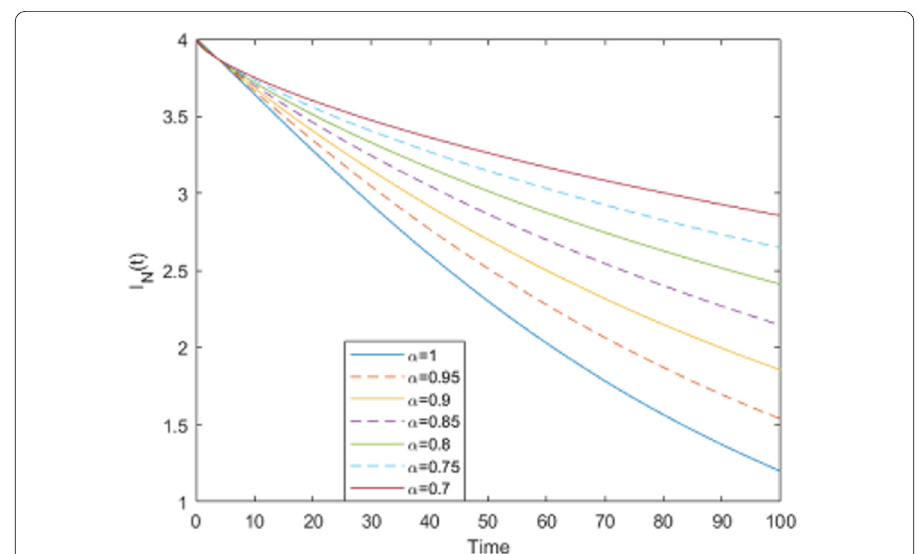
Figure 11 The class of researchers affected but with negative opinion